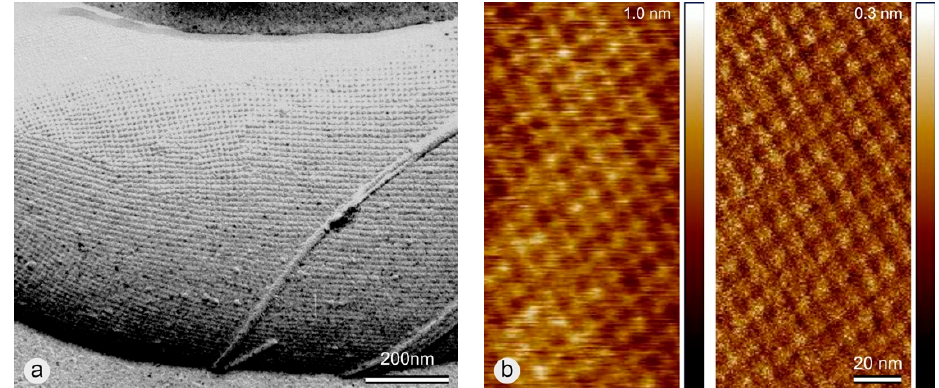
Figure 1. ( a ) TEM micrograph of a freeze-etched and metal shadowed preparation of a bacterial cell of Lysinibacillus sphaericus CCM 2177 with an S-layer as the outermost cell envelope component. The numerous lattice faults are a consequence of the bending of the S-layer lattice at the rounded cell poles. In addition, the rope-like structures are the flagella of the bacterial cell. (Reproduced from Reference [26] with permission from the Royal Society of Chemistry.) ( b ) AFM images of a monolayer of the SbpA S-layer lattice of Lysinibacillus sphaericus CCM 2177 on a silicon wafer. (Height image (left) and deflection error image (right)). The S-layer lattice shows square lattice symmetry. Unit cell size is 13.1 × 13.1.